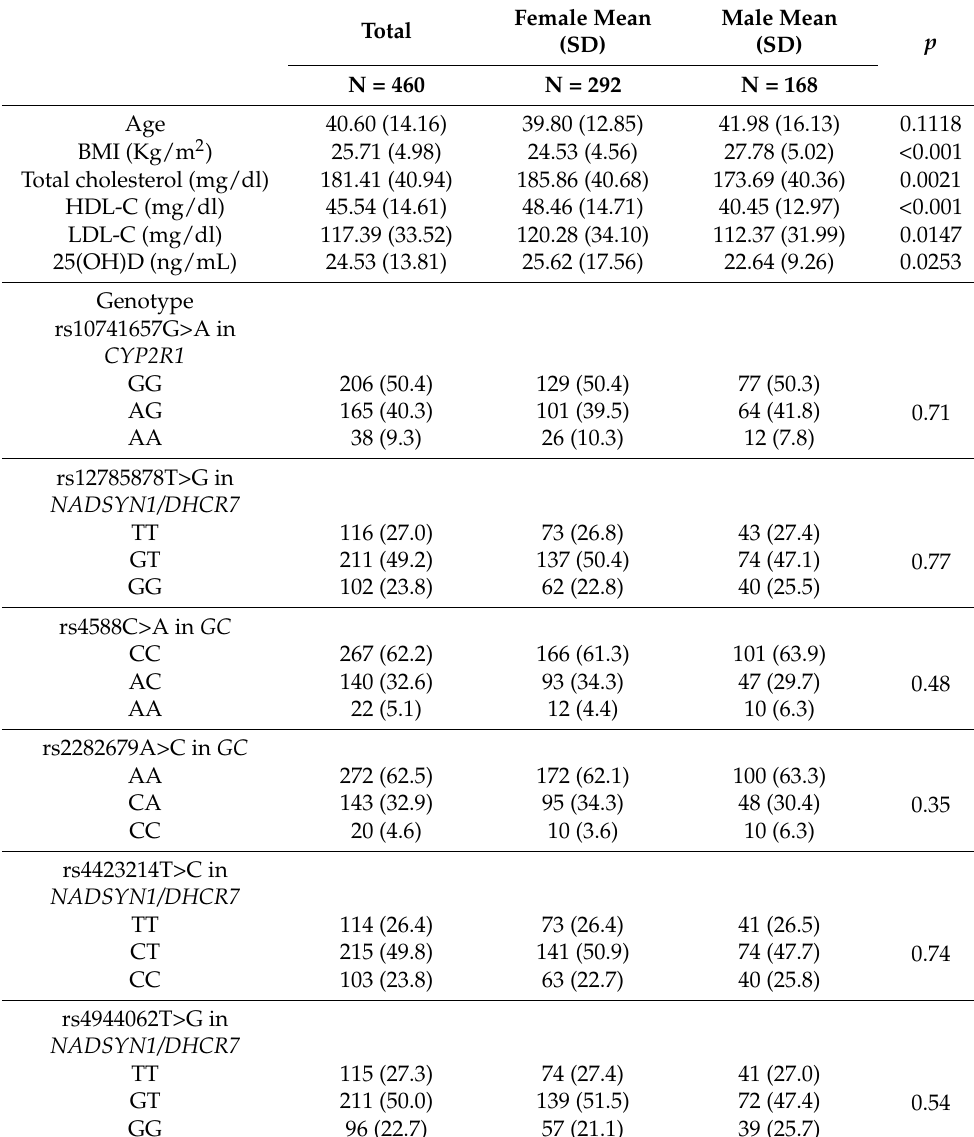
Table 1. Demographic, clinical, and genetic characteristics of the study